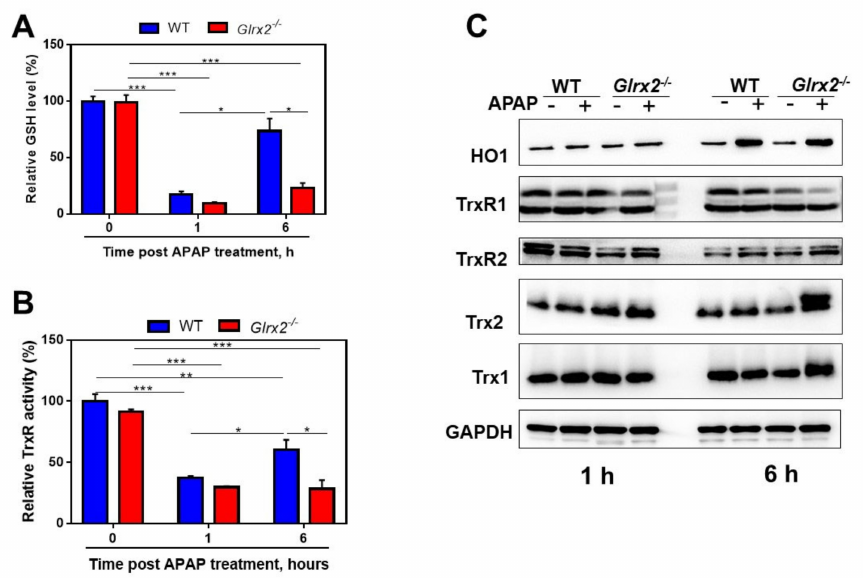
Figure 2. Glrx2 deficiency weakened the compensatory response of thiol-antioxidant systems. ( A ) The effect of Glrx2 knockout on glutathione (GSH) level in the livers from APAP-treated mice. ( B ) The effect of Glrx2 knockout on thioredoxin reductase (TrxR) activity in livers from the mice exposed to APAP. ( A , B ) Statistical difference between the groups was analyzed by two-way ANOVA. Data are shown as mean ± SEM, n = 5, * p < 0.05; ** p < 0.01; *** p < 0.001. ( C ) The effects of Glrx2 knockout on the protein expression levels of Trx systems in the liver from the mice treated with APAP; n = 4, a representative one is